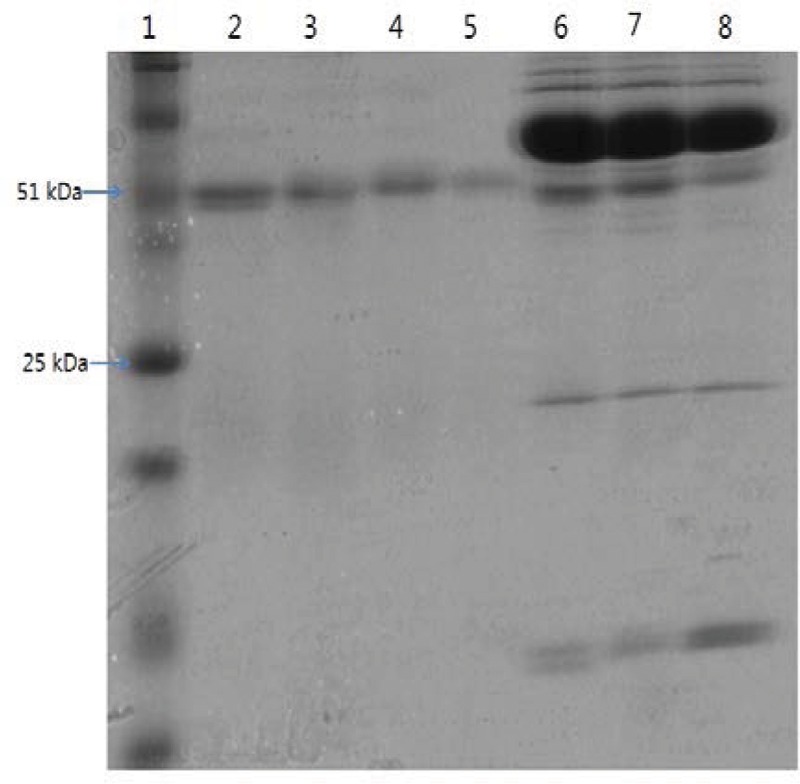
Sodium dodecyl sulfate-polyacrylamide gel electrophoresis of developed rabbit anti-Cronobacter IgG and anti-serum. Lane 1: standard protein marker, lane 2: commercial rabbit IgG, lane 3: anti-Cronobacter IgG developed from sonicated cell protein mixture of Cronobacter spp., lane 4: anti-Cronobacter IgG developed from formalin killed cells mixture of Cronobacter spp., lane 5: anti-Cronobacter IgG developed from lipopolysaccharide mixture of Cronobacter spp., lane 6: anti-serum developed from sonicated cell protein mixture of Cronobacter spp., lane 7: anti-serum developed from formalin killed cells mixture of Cronobacter spp., lane 8: anti-serum developed from lipopolysaccharide mixture of Cronobacter spp.